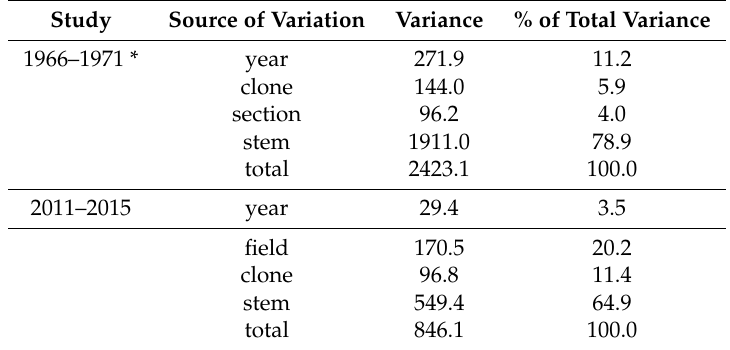
Table 1. Variance in percent fruit set explained by year, field, clone, and stems.